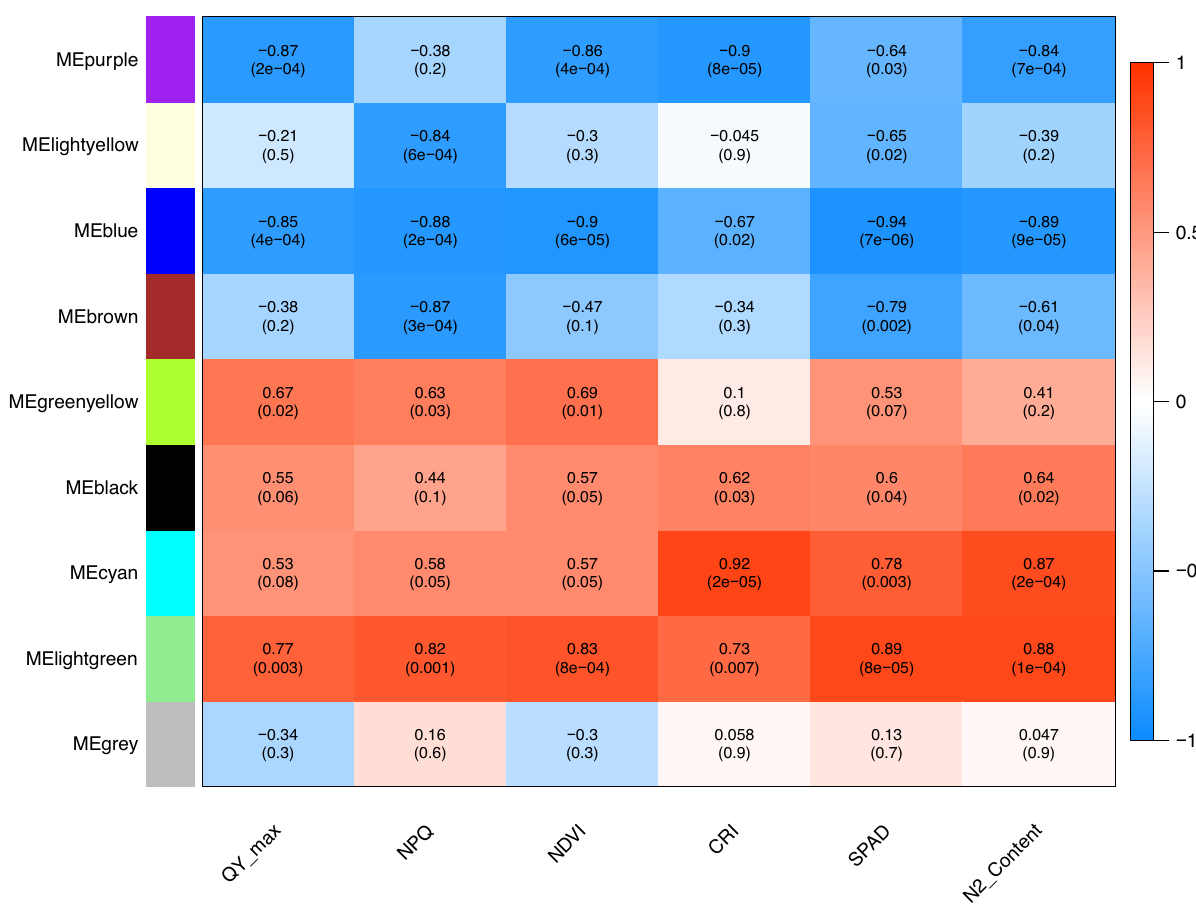
Figure 8. Heat map of relationship between modules and phenotypic traits. The color indicated direction of correlation, values represent Pearson correlation coefficients, and P-values are in